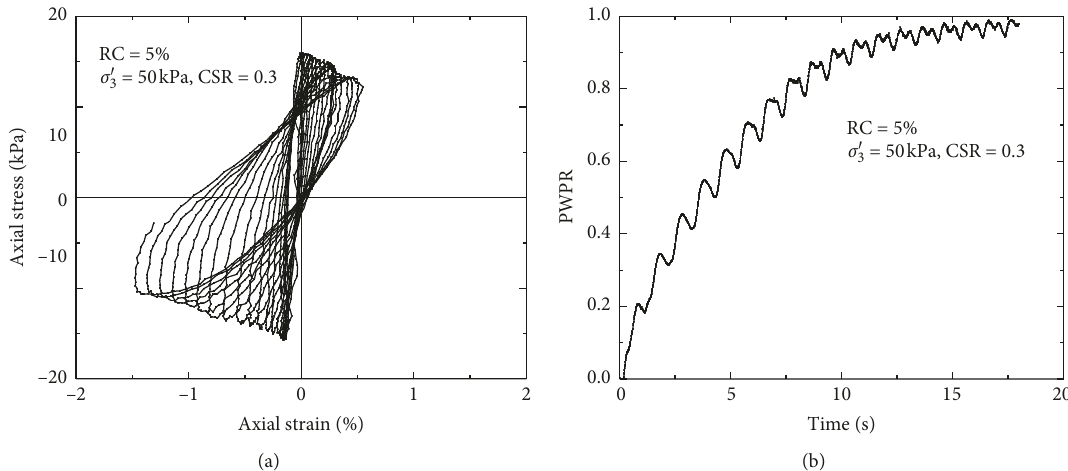
Figure 8: Typical experimental results for RC � 5%, σ histories of PWPR.